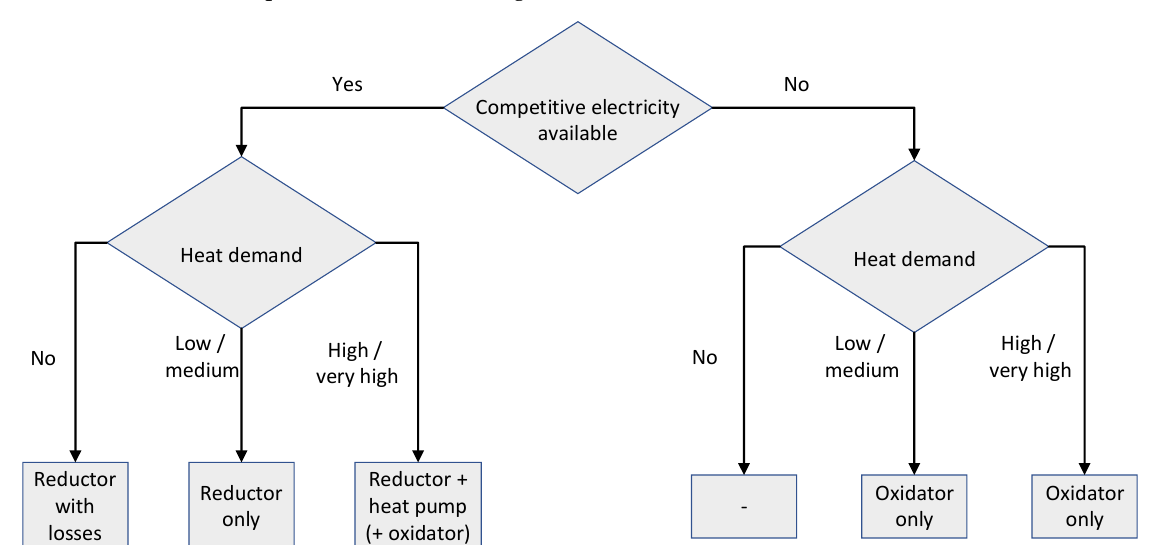
Figure 2. Schematic of the TCES plant proposed in this work, based on a high-temperature redox cycle. The plant absorbs VRE to produce hydrogen in the electrolyzer together with nondispatchable heat for the DH network. The hydrogen is then used to reduce a metal.